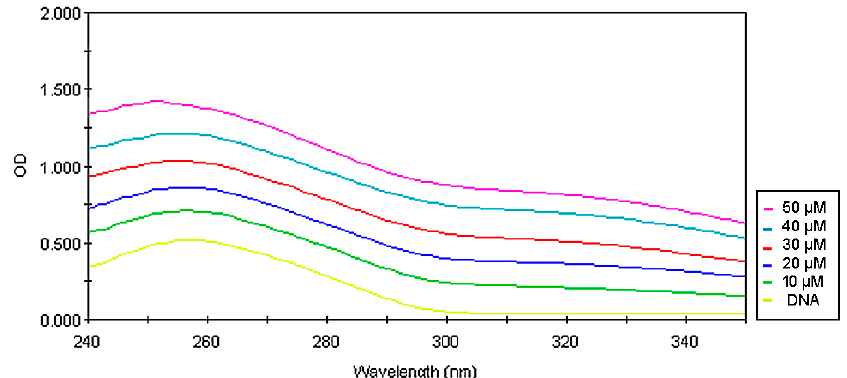
Figure 10. Absorption spectra of calf thymus DNA (250 µg/mL) in phosphate buffer (pH 7.4) upon addition of compound 1 (10, 20, 30, 40, and 50 µM, respectively).